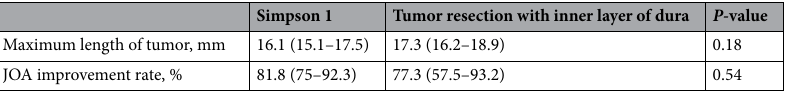
Table 4. Tumor size and patients’ clinical results according to Japanese Orthopaedic Association score. JOA improvement rate (%) = ([post JOAs] − [pre JOAs] / [total JOAs] – [pre JOAs]) × 100. JOAs: Japanese Orthopaedic Association score. Data are presented as the median (interquartile range) and were analyzed with the Wilcoxon